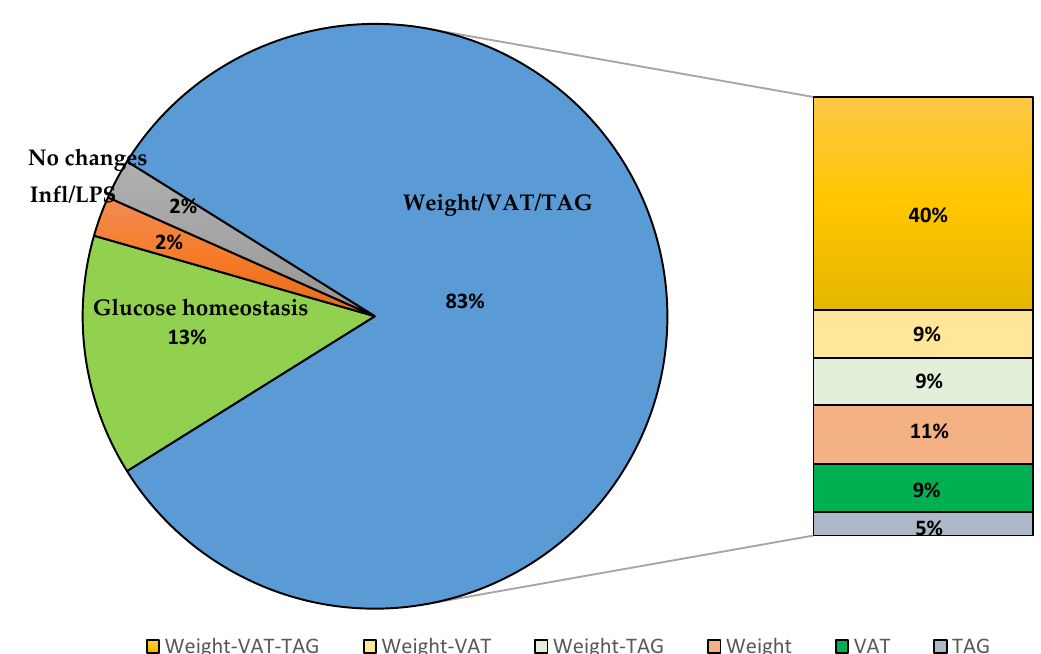
Figure 2. Overall effect of the phenolic intervention on metabolic parameters. VAT-visceral adipose tissue, TAG-triacylglyceride, Inf-inflammatory markers, LPS-lipopolysaccharide.